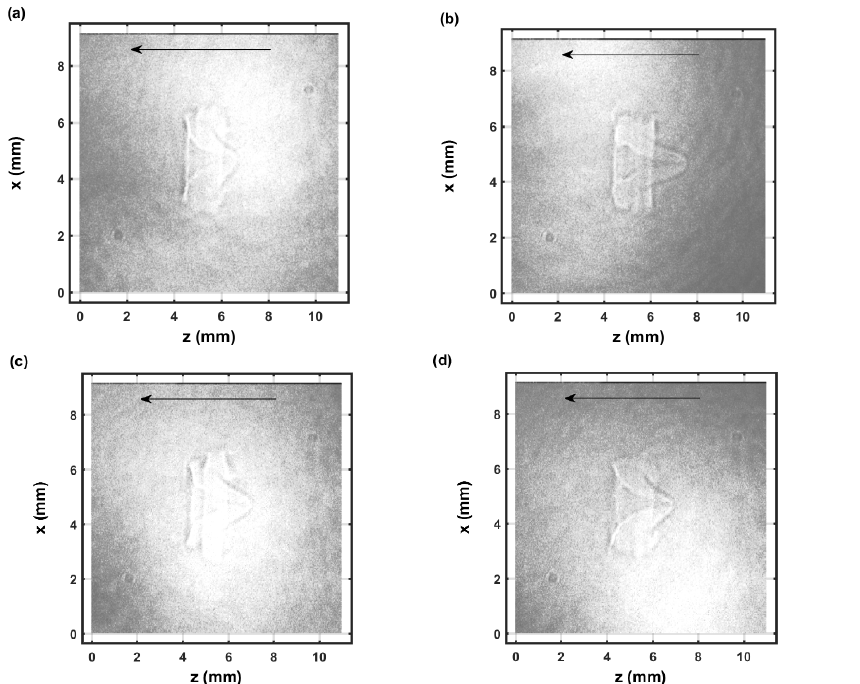
Figure 6. Single-shot shadow graph of the expanding laser-induced plasma initiated with a 170-mJ, 6-ns, 1064-nm focused beam, and imaged using a 5-ns, 532-nm back-light that shows intensity variations and is time-delayed by 54.25 µ s ( a – d ) display images from separate laser